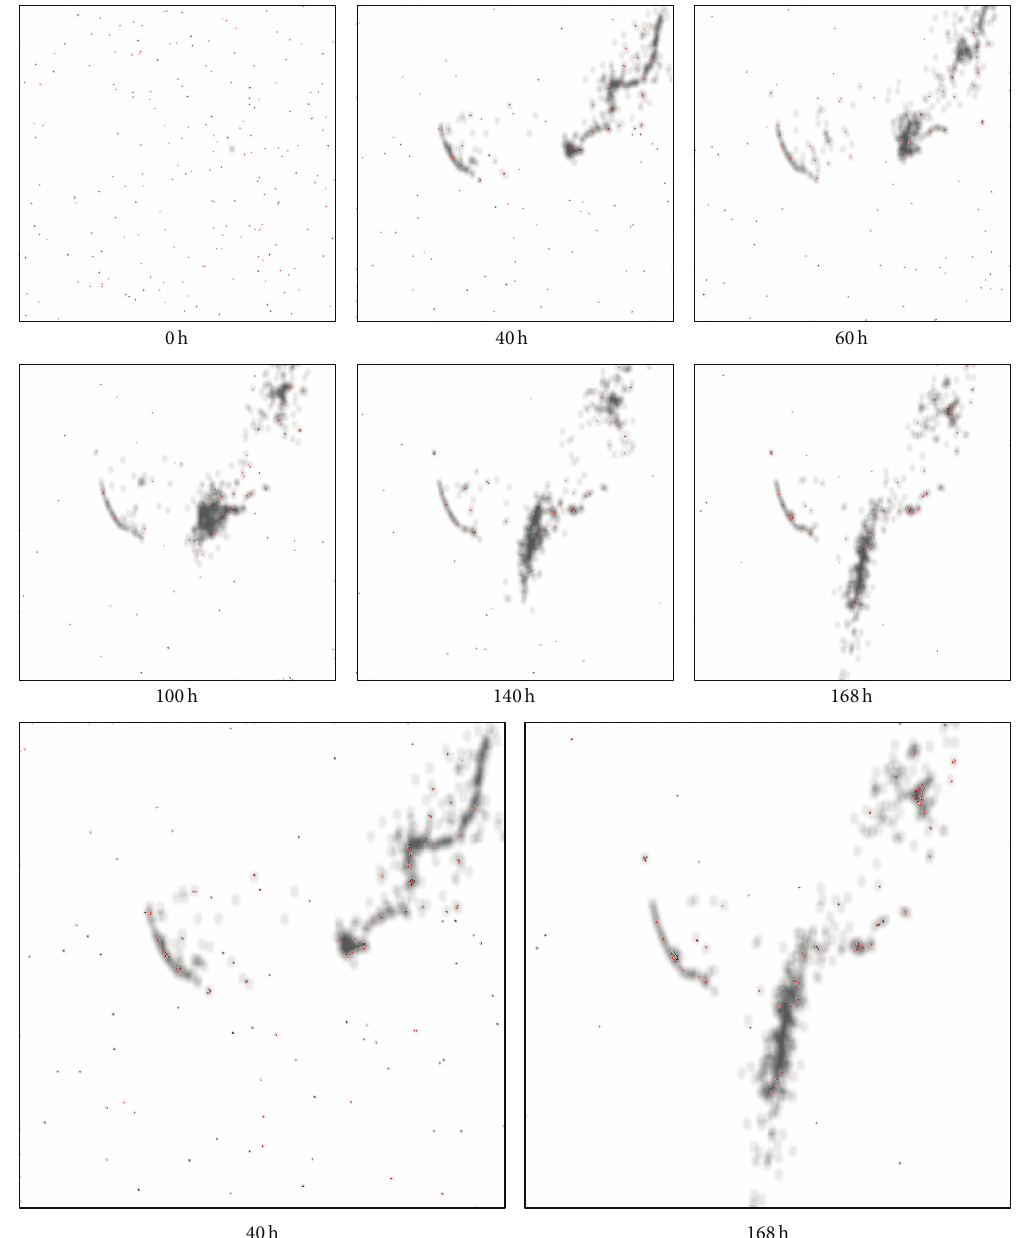
Figure 8: Evolution of the swarm with respect to the oil slick. Multiple snapshots at different instants in time (measured in hours) are shown.